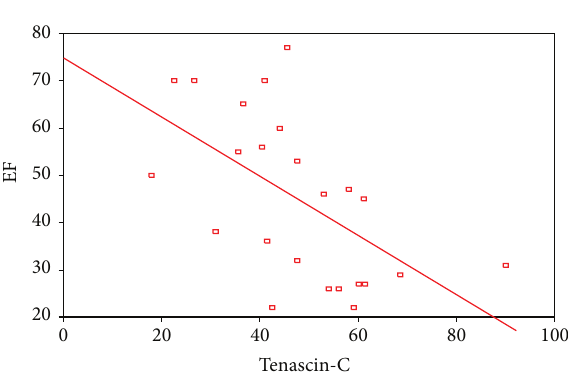
Figure 1: A negative correlation between serum tenascin-c level and ejection fraction in patients.